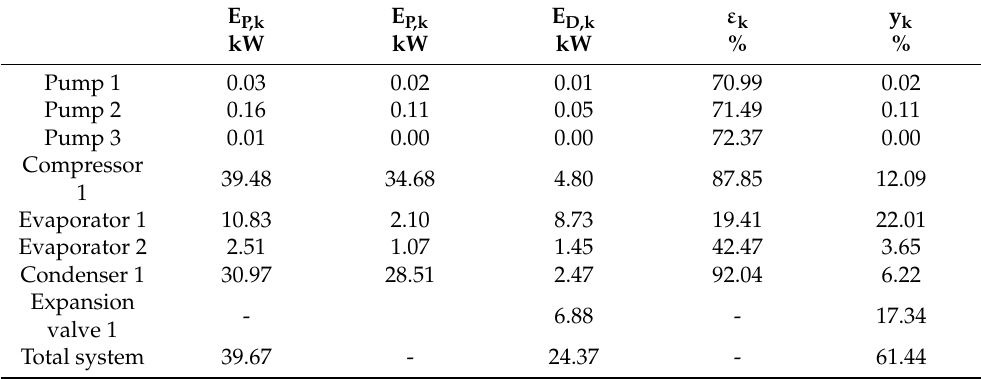
Table A4. Exergy calculation results of case